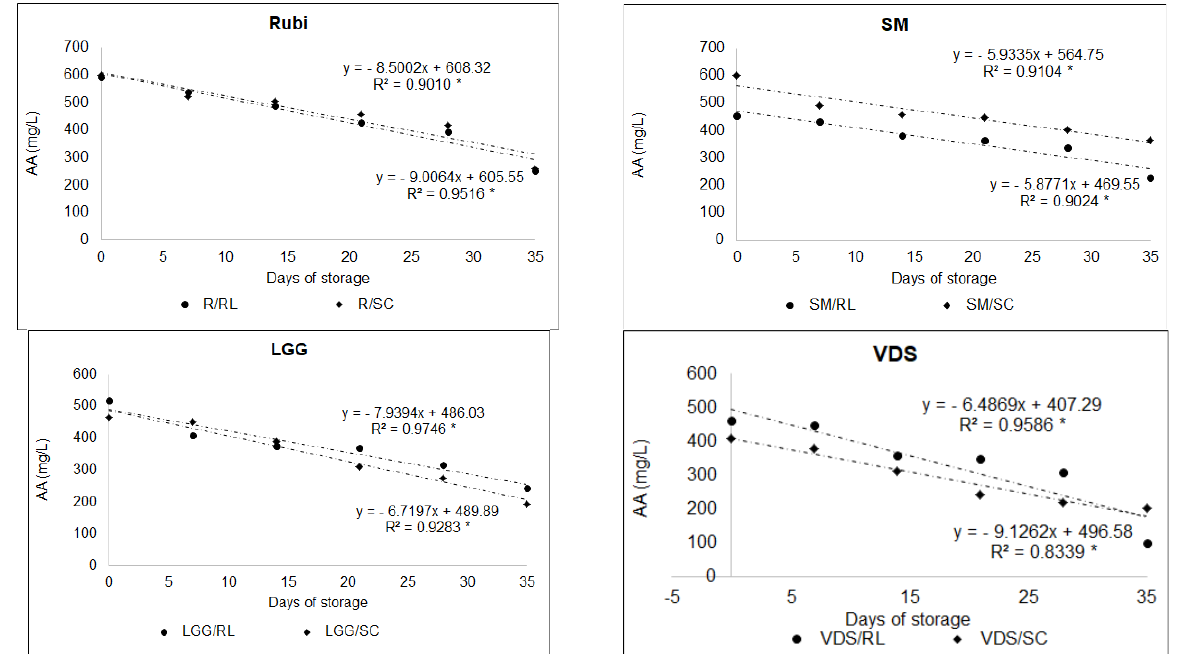
Figure 2. Ascorbic acid concentration (mg/L) in juices of Sanguínea de Mombuca (SM), Rubi (R), Lue Gin Gong (LGG), and Valencia Delta Seedless (VDS) sweet orange cultivars with different rootstock combinations subjected to 0, 7, 14, 21, 28, and 35 days of storage. RL —‘Ranpur’ lime; SC —‘Swingle’ citrumelo.